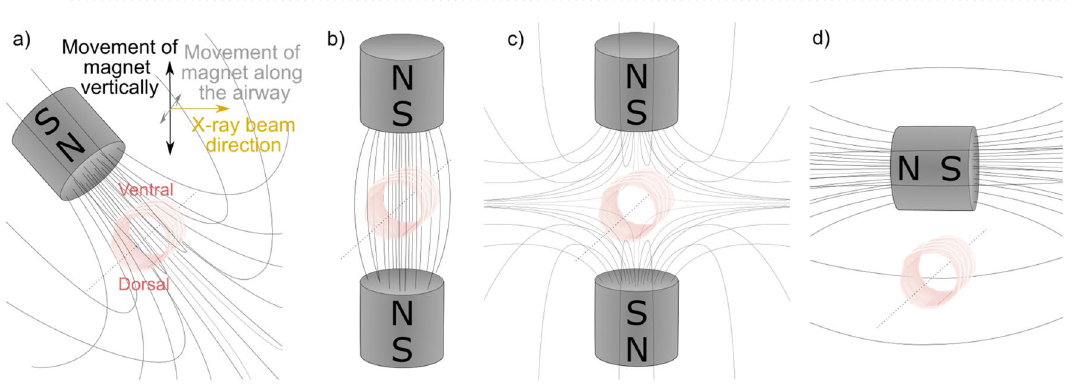
Figure 3. Magnet configurations for in-vivo imaging ( a ) Single magnet above trachea at ~ 30° angle, ( b ) two magnets set up to attract, ( c ) two magnets set up to repel, ( d ) a single magnet above and perpendicular to the trachea. The viewer looks down through the trachea from the mouth towards the lungs, with the X-ray beam passing into the rat’s left side and out its right side. The magnet was moved either along the length of the airway, or left and right above the trachea in the direction of the X-ray